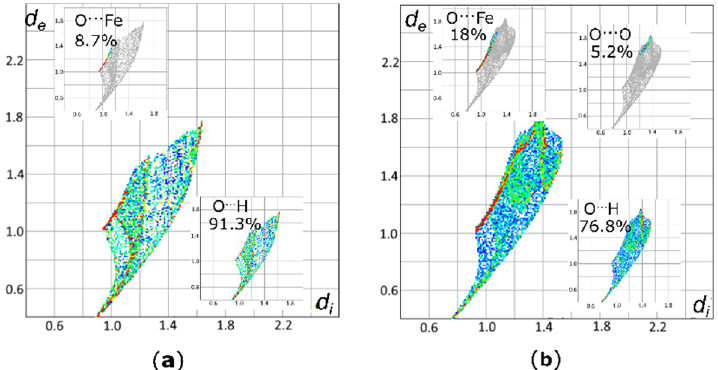
Figure 6. Fingerprint plots (FPs) for the Hirshfeld surface (HS) of ( a ) O1 and ( b ) O2 atoms. The extracted FP for particular contacts are presented together with their respective contributions.